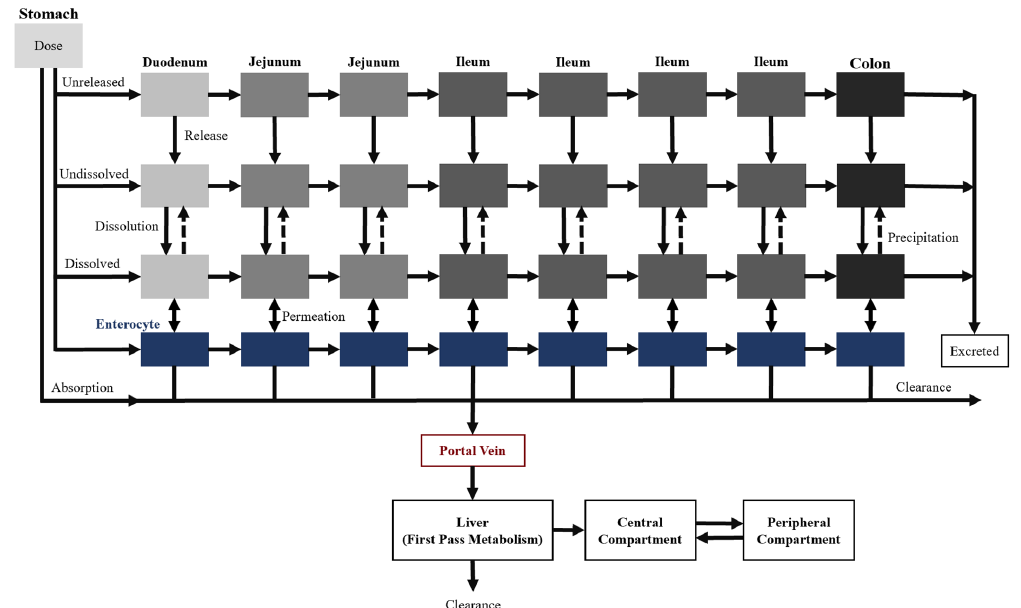
Figure 4. Schematic of the advanced compartmental absorption and transit (ACAT)